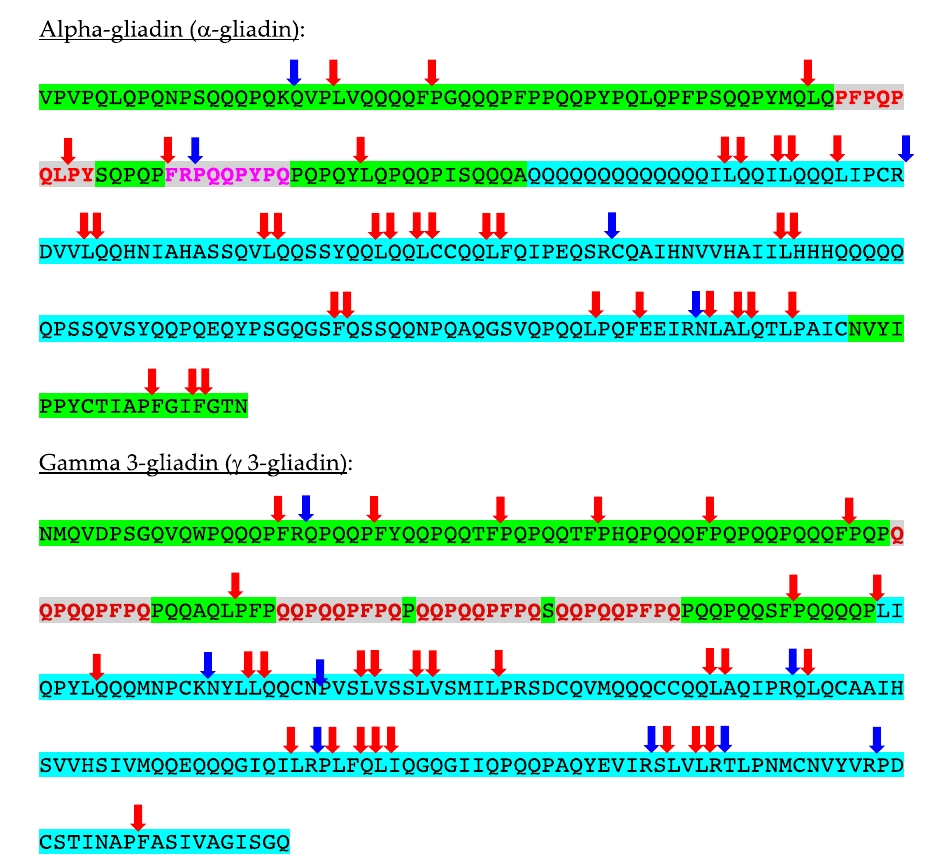
7 Figure 4. Ribbon diagram ( A ) of the three ‐ dimensional model retrieved from the AlphaFold Protein Structure Databank (https://www.alphafold.com, accessed on 22 August 2022). The signal peptide,